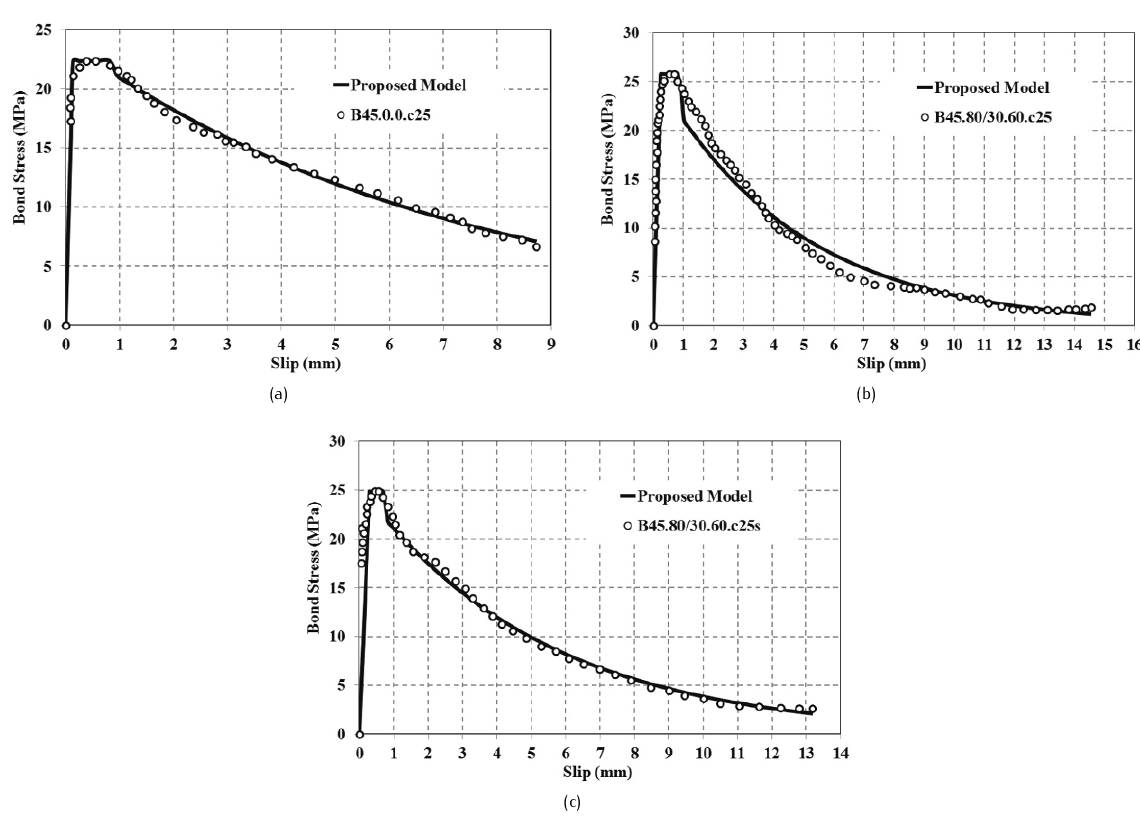
Figure 14. Comparison of the experimentally obtained load-slip curves (Schumacher [30]) versus the predicted curves by using the proposed model for (a) f 0 c = 45 , without fiber and concrete cover = 25, (b) f 0 c = 45 , with fiber “aspect ratio: 80/30” and “fiber content: 60 (kg/m 3 )”, and concrete cover = 25, and (c) f 0 c = 45 , with fiber “aspect ratio: 45/30” and “fiber content: 60 (kg/m 3 )”, and concrete cover = 25 sawn cast.